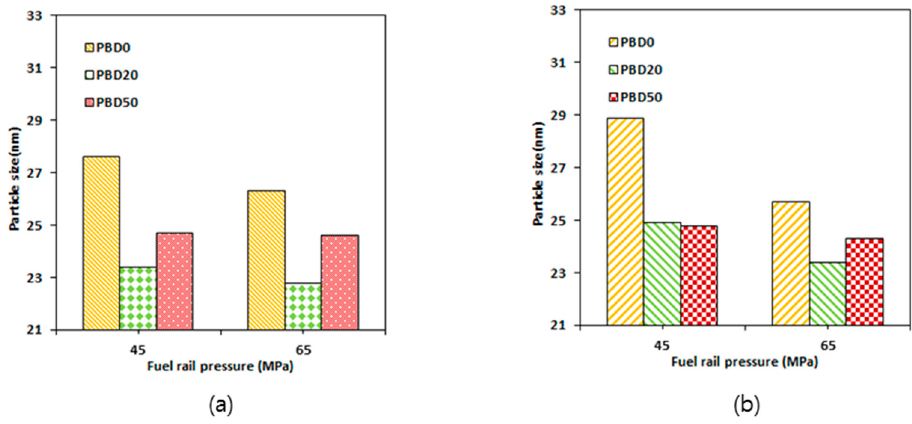
ff erent engine loads of ( a ) 50 Nm ( b ) 100